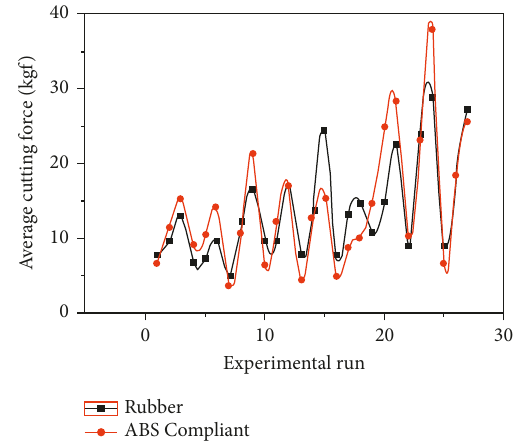
Figure 8: Comparison of surface roughness with the rubber and ABS compliant